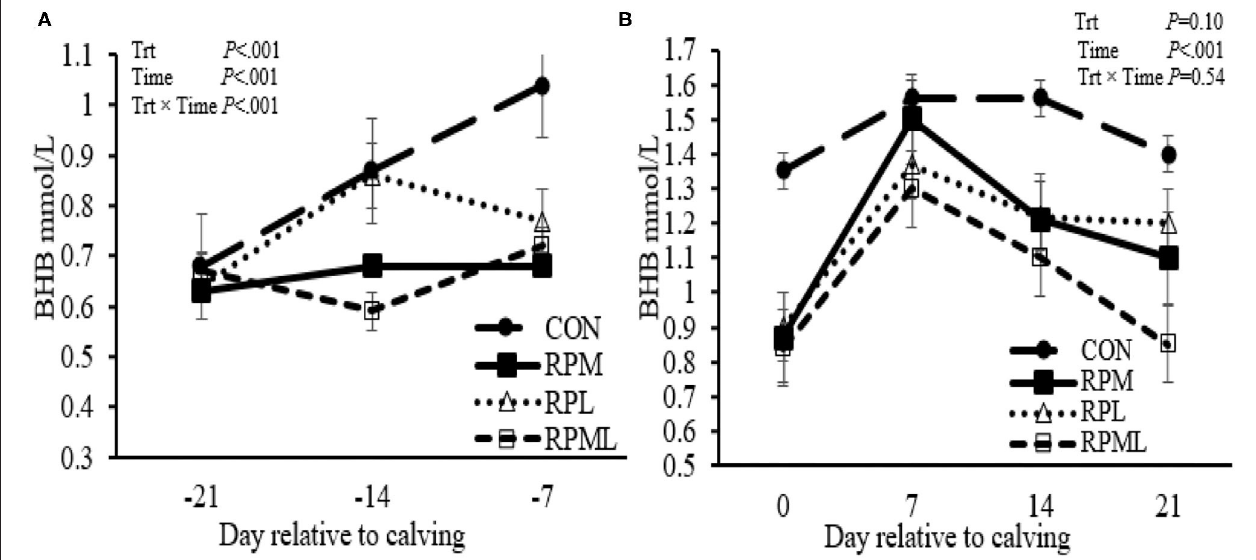
FIGURE 2 | Effect of ruminally protected Lys and Met supplementation on blood β -hydroxybutyrate concentration of Holstein dairy cows during the transition period. Values are means; standard errors are represented by vertical bars.